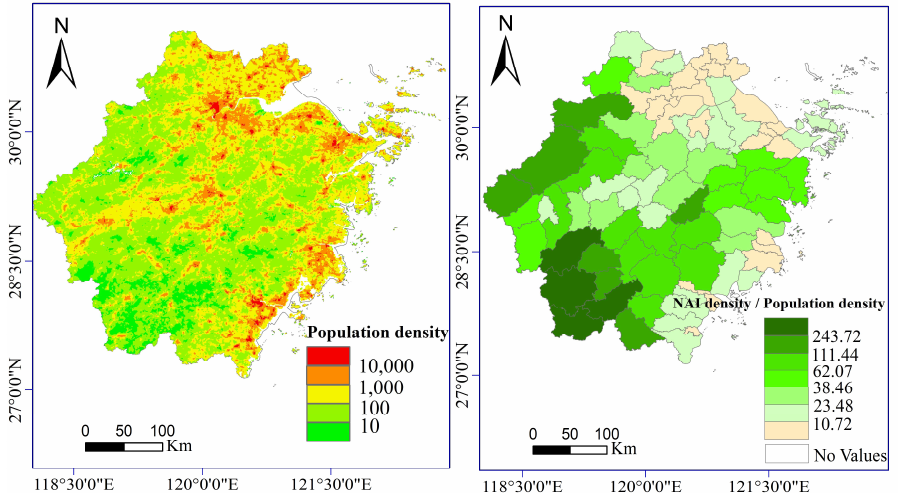
Figure 11. The population density and the ratio of annual mean NAI concentrations to population density in the different counties of Zhejiang province. Table 3. The mean DEM and slope of each land type in Zhejiang